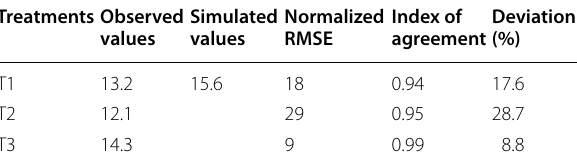
Table 3 Observed versus simulated results for validated data sets of sunflower yield during 2016–2017 Treatments Observed values